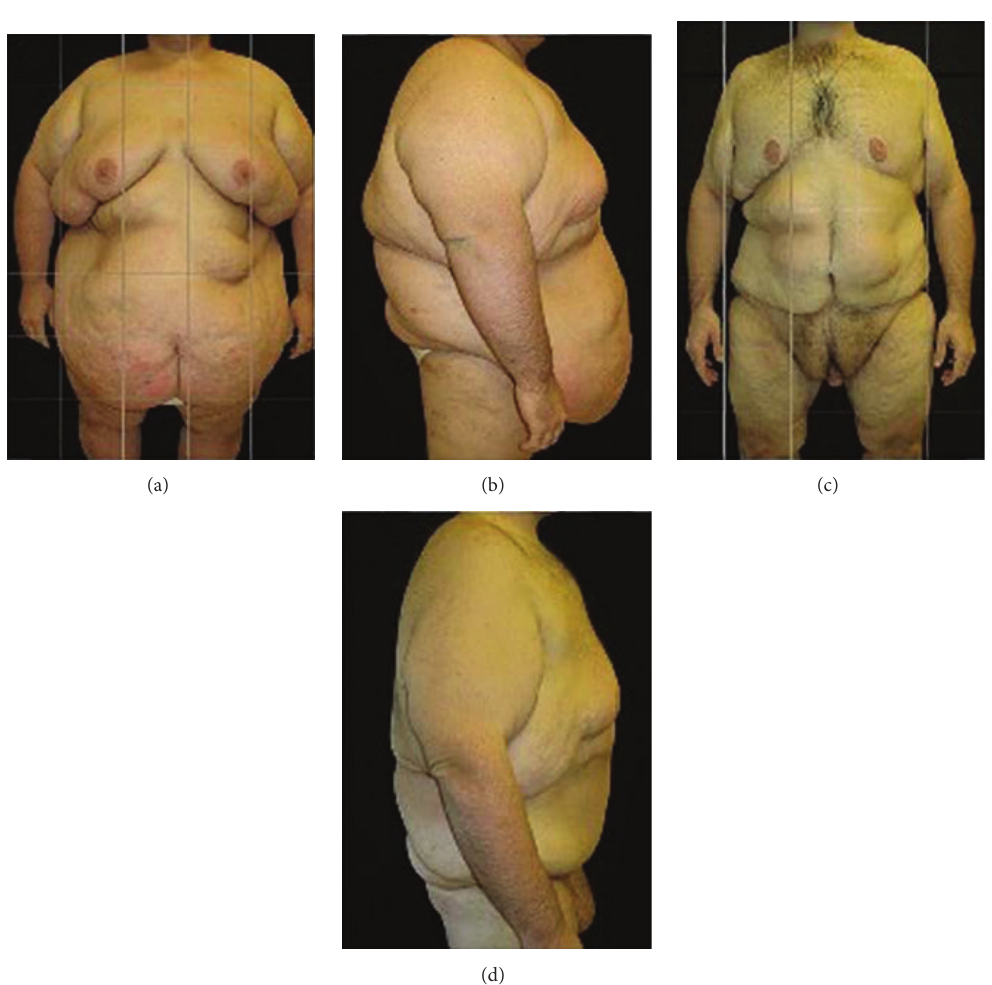
Figure 3: (a) Preoperative frontal view and (b) lateral view of a male patient (BMI = 69.9 kg/m 2 ; body weight = 220 kg). (c) Postoperative frontal view and (d) lateral view five years after surgery (body weight = 110kg).